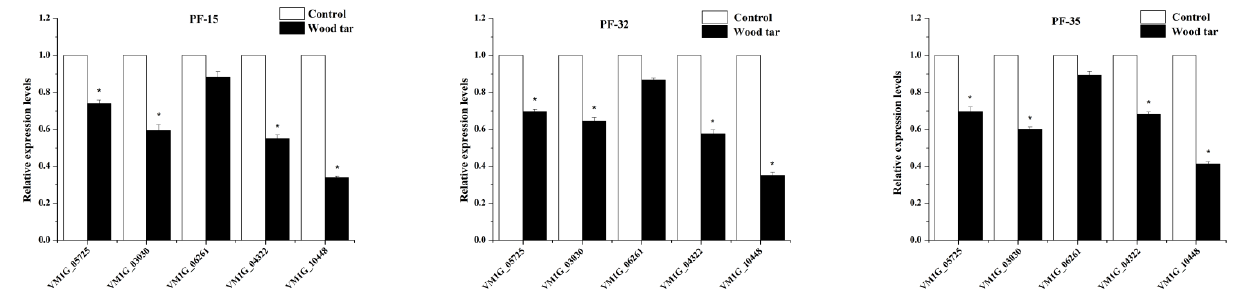
Figure 4. Relative expression levels of these five genes in three wild-type V. mali strains: PF-15, PF-32, and PF-35. The mean and standard error of three independent experiments is presented numerically. Asterisks indicate significant differences from controls according to Student’s t -test: * p < 0.05.